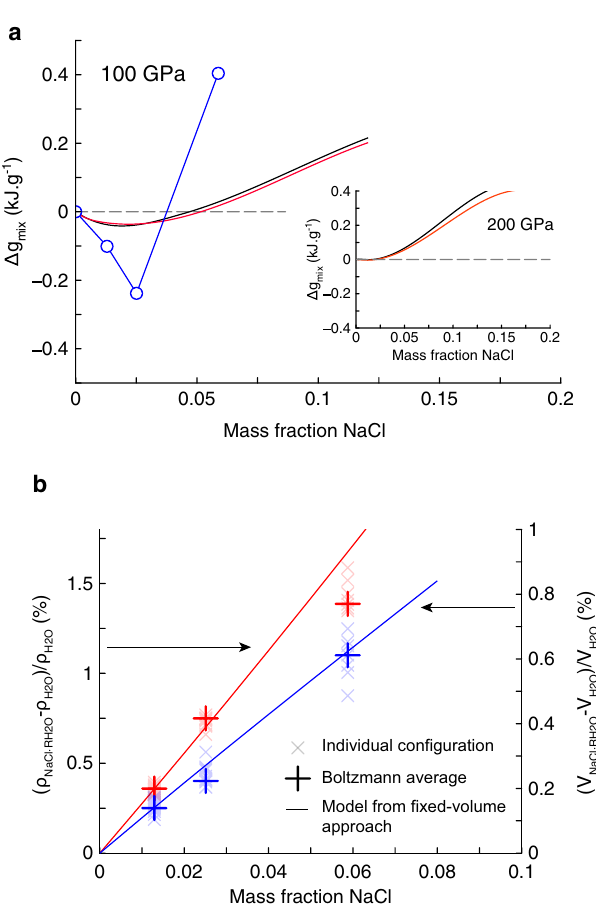
Fig. 4 Thermodynamics of NaCl· R H 2 O mixture at 1600 K and 100 GPa. a Gibbs free energy of mixing Δ g mix as computed from a fi xed pressure approach and a complete sampling of the reduced con fi guration space (blue circles). In this case the con fi guration entropy is exact. Black (with correction for the GGA volume overestimation in B2 NaCl) and red (without) lines correspond to Δ g mix calculated from the fi xed volume approach (see text and Supplementary Information) and a random sampling of the entire con fi guration space. Due to the limited sampling, the con fi guration entropy is less constrained in this approach. Inset: Δ g mix at 200 GPa and 1600 K. b Relative volume (blue) and density (red) differences between NaCl (cid:3) R H 2 O and H 2 O. Crosses corresponds to individual con fi gurations and pluses to Boltzmann averages obtained from the complete sampling of the reduced con fi guration space. Lines correspond to the model derived from the fi xed volume